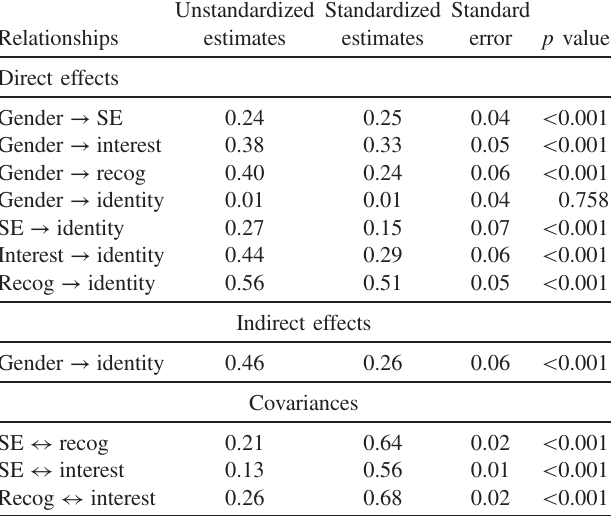
TABLE IV. Results of the path analysis part of SEM model 1 for physics 1. Recog represents perceived recognition. SE represents self-efficacy. Single-headed arrows represent direct or indirect regression relationships. Double-headed arrows represent covariances.